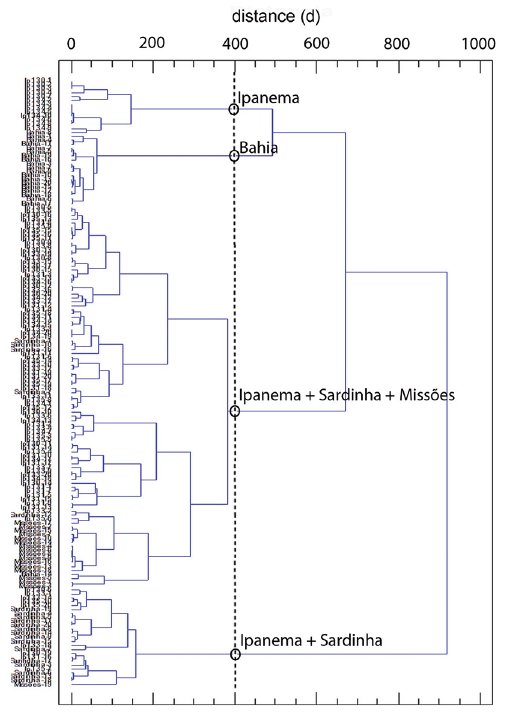
Figure 6: Dendrogram using the treated EDX results of the wüstite phase of the slag inclusions. to magmatic origins 22 , which is the case of the carbonatite of the Araçoiaba hill. By contrast, TiO